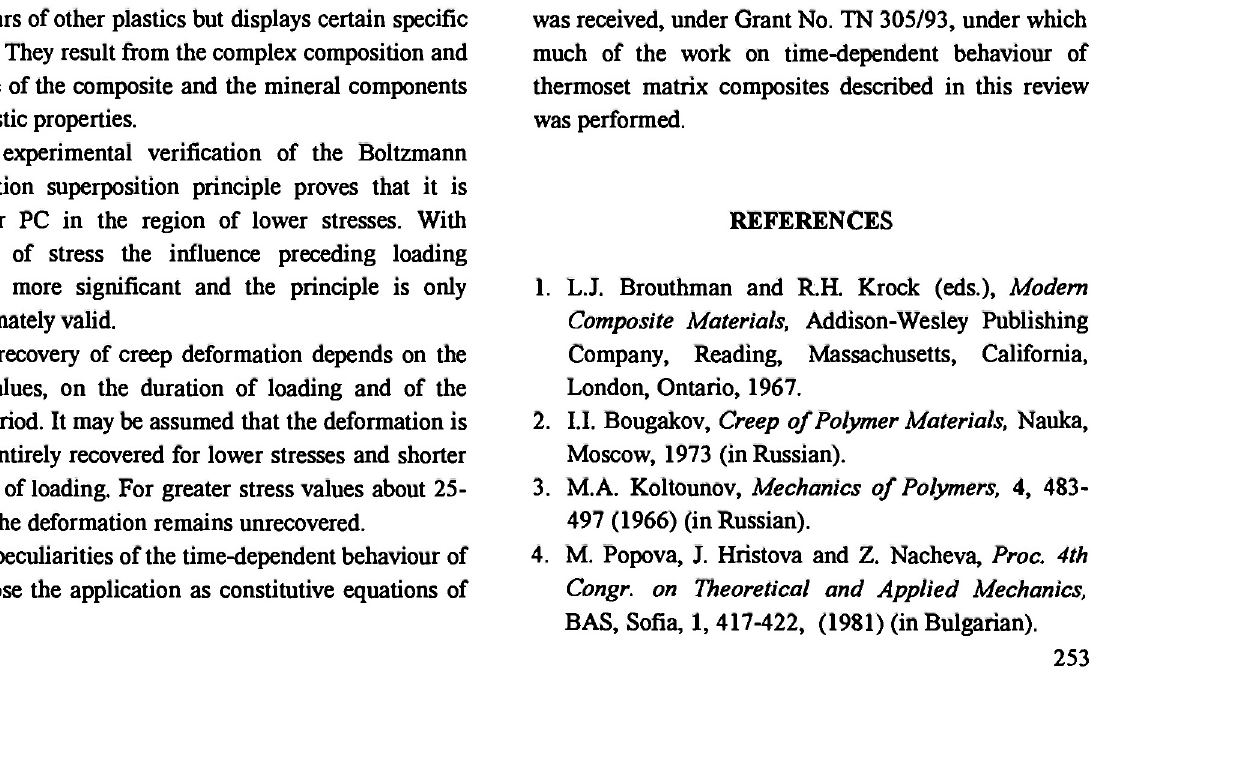
Fig. 7: Experimental and theoretical values of PC creep under cyclic